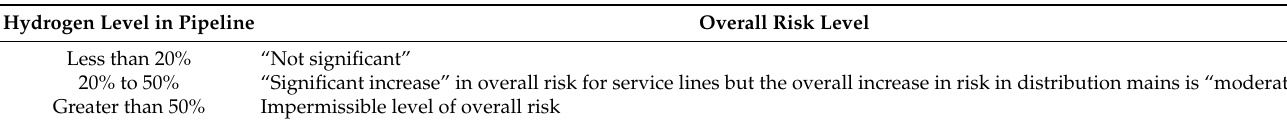
Table 2. Hydrogen levels and their associated risks in blended pipelines [18].